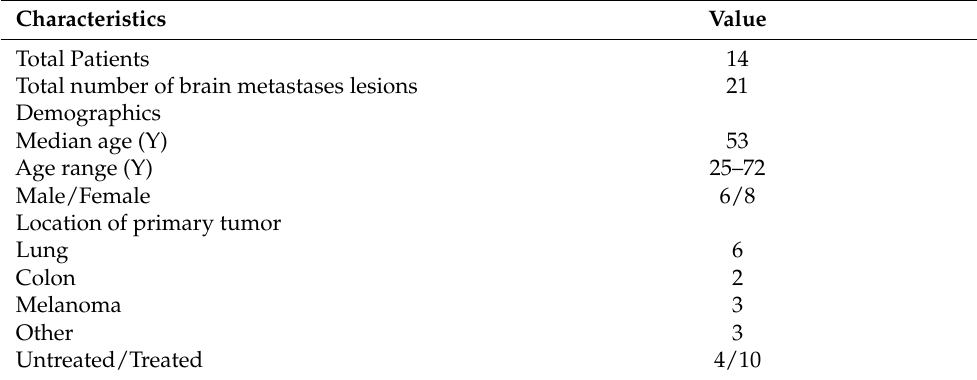
Table 1. Patient